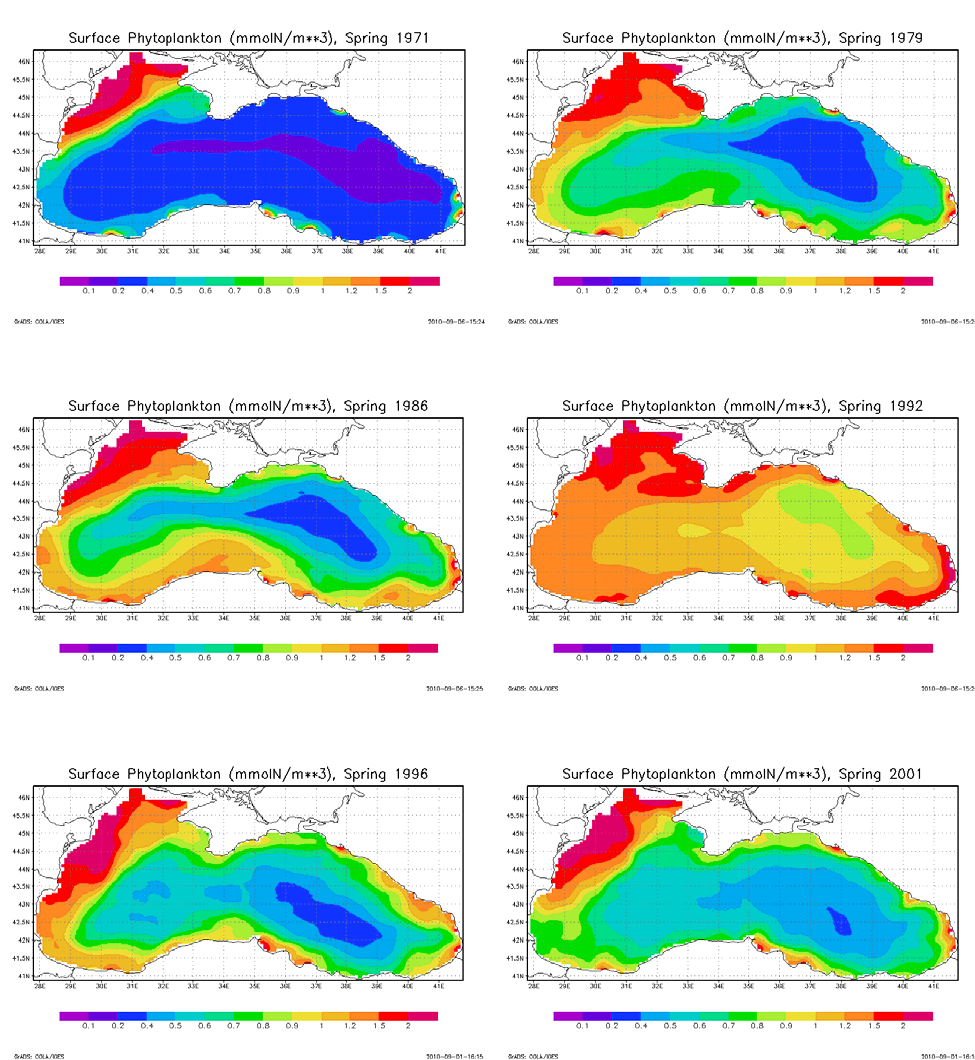
Figure 21 Spring-mean maps of the surface phytoplankton distribution for different years. the biogeochemical model were the results obtained with the POM circulation